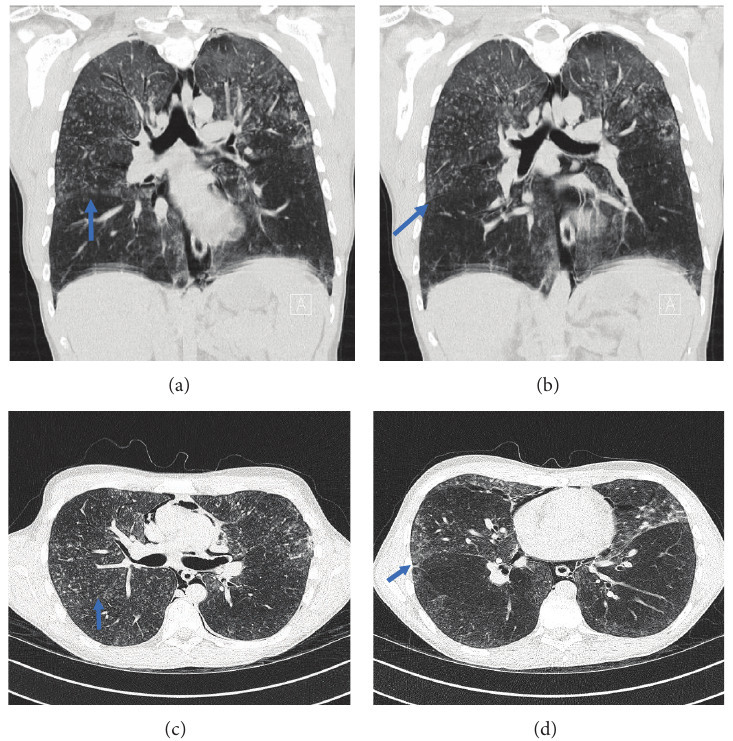
Figure 3: CT scan. (a)-(b) Coronal sections showing the bifurcation of the bronchus to the apical segment and the basal segments. There is no evidence of accessory branching, so no morphological extra lobe; hence there is only an accessory fissure (arrows). CT scans (a) and (b) have respiratory artifacts as seen at the level of the diaphragm. (c)-(d) Transversal sections showing the superior accessory fissure of the lower lobe of the right